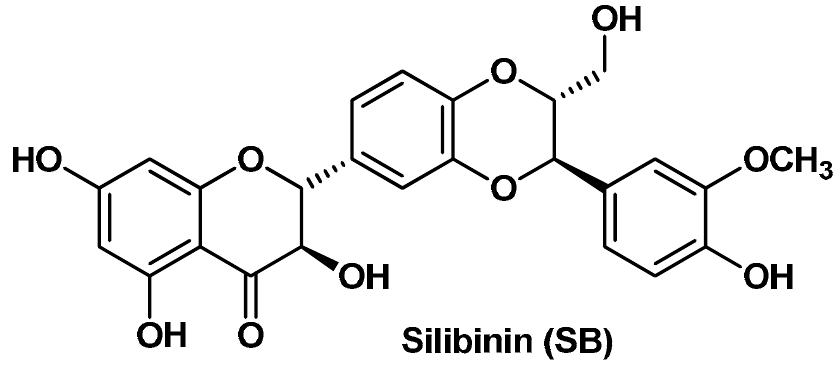
Figure 4. Chemical structure of Silibinin